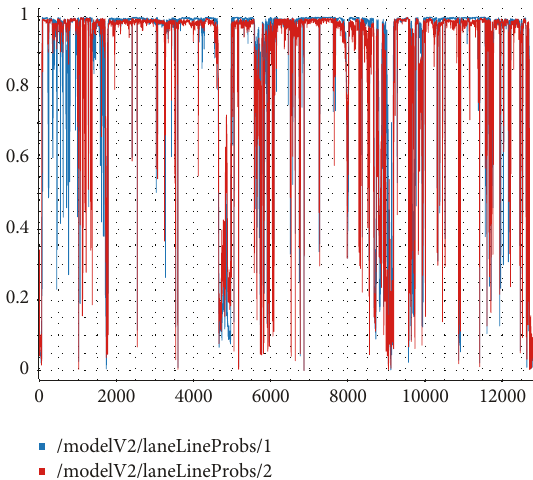
Figure 53: T2N1 left (1) and right (2) lane recognition.